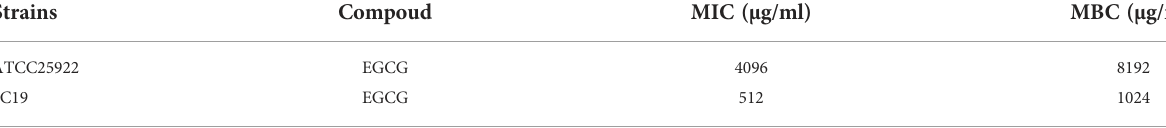
TABLE 1 MIC and MBC values of EGCG against SC19 and ATCC25922.